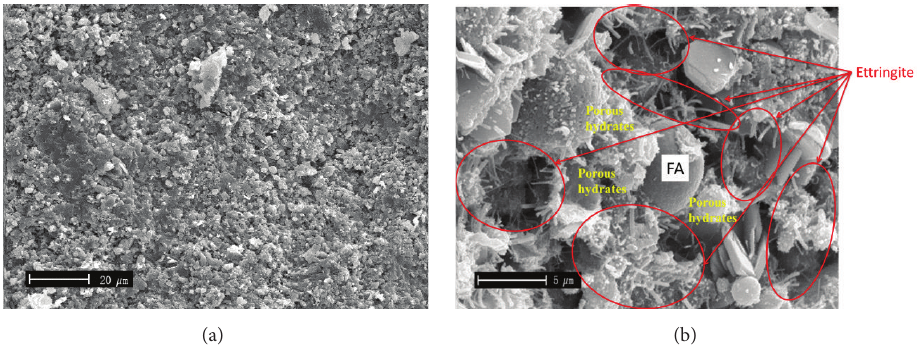
Figure 4: SEM images of microstructure of PC at 20 ∘ C at (a) 2000x and (b) 10000x magnification.